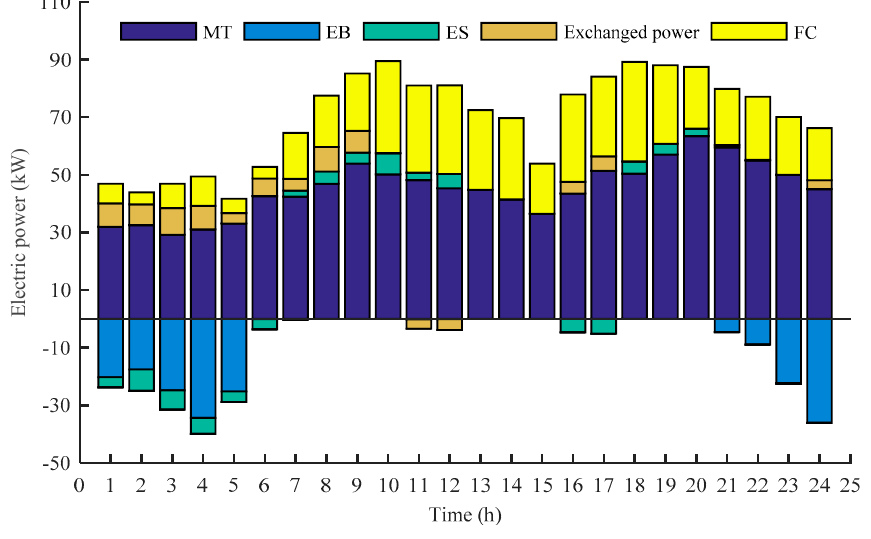
Figure 12. Results of electric power.